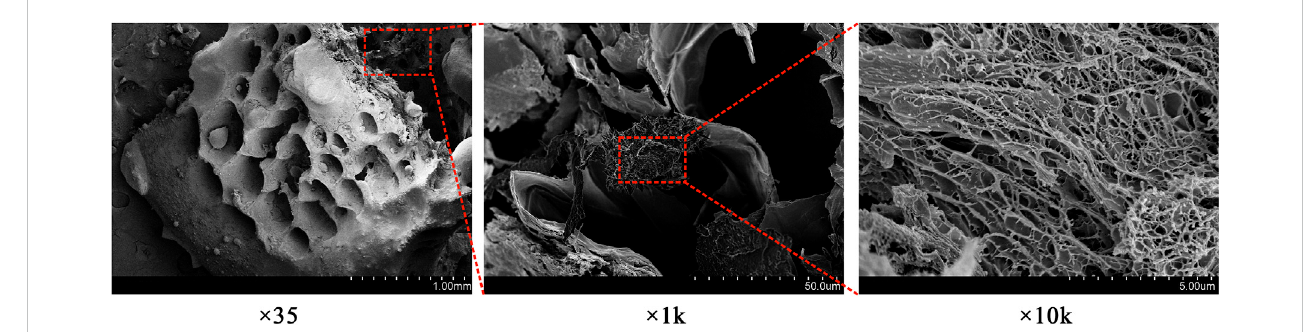
FIGURE 4 Electron microscope scan of FDBM.